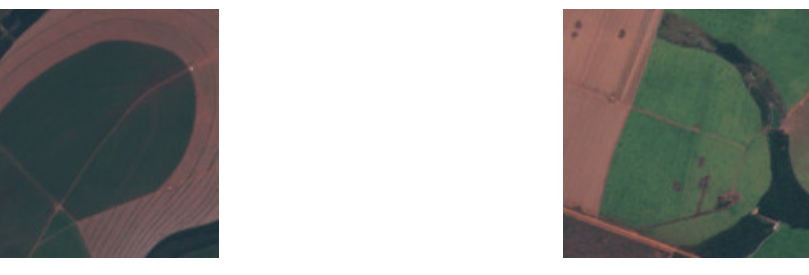
Figure 10. Examples of false detections after the recognition of GoogLeNet.